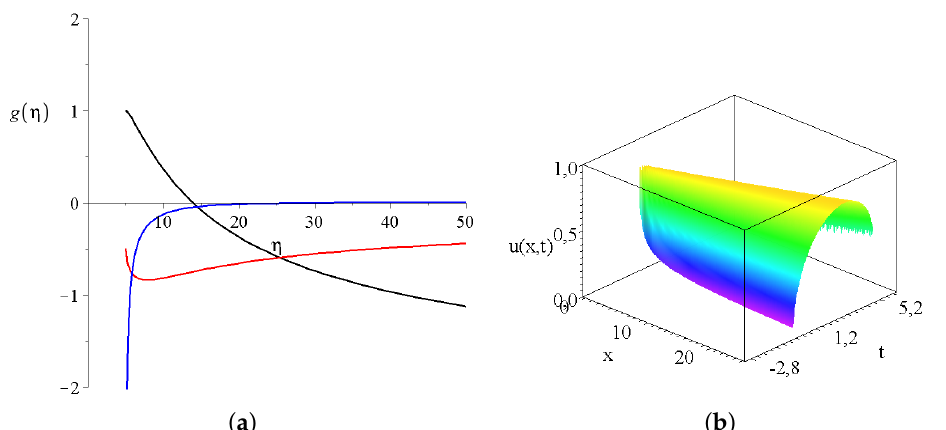
Figure 5. The shape function and the solution for the spatial and temporal dependence of the x component of the wave velocity. ( a ) The shape function of the x velocity component g ( η ) for the above given three α exponents for the time-independent seabed function. The black, red and blue lines correspond to α = − 1,0 and 1 values, respectively. The integral constants c 1 = c 2 = c 3 = 1 and the geometrical constants are a = b = 1 and c = 0; ( b ) the spatial and temporal dependence of velocity component u ( x , y = 0, t ) for α = 0; all other constants remain the same.